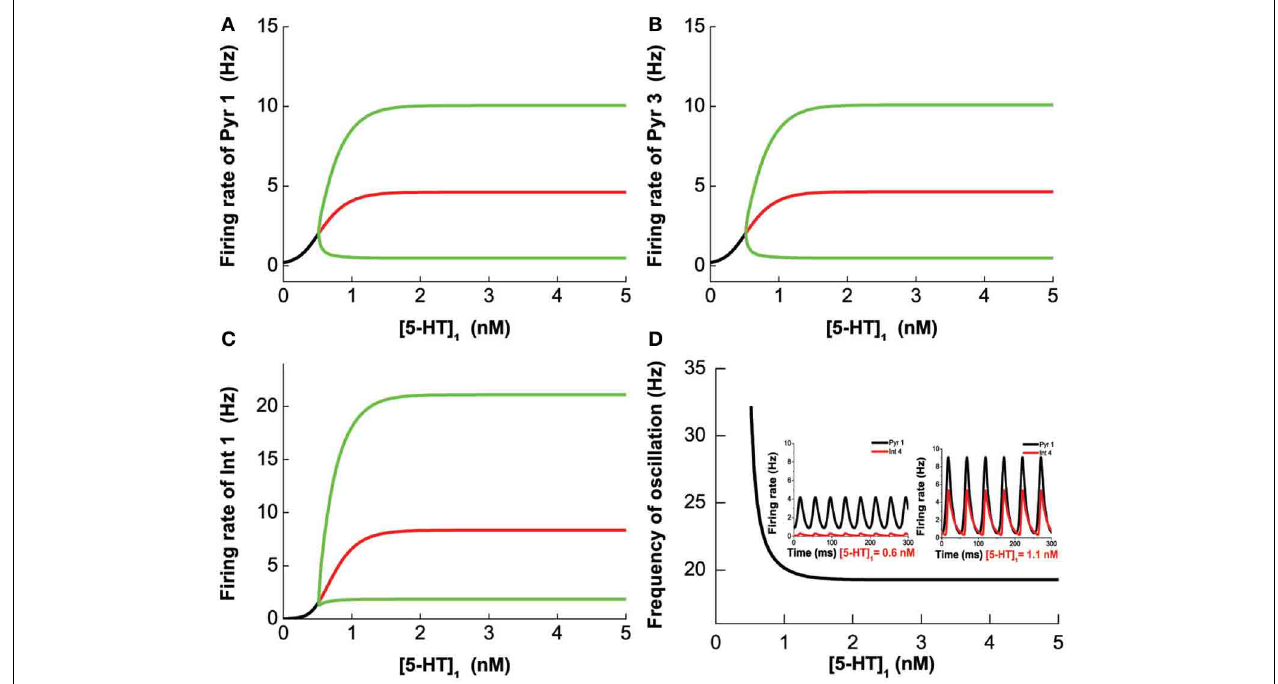
FIGURE 12 | 5-HT1A selective agonist/antagonist effects on the network behavior. The oscillation merges through Hopf bifurcation at [5- HT ] 1 = 0 . 516nM. The amplitude increases with increasing [5- HT ] 1 and reaches a plateau after almost all of 5-HT1A receptor are blocked. Firing rate of pyramidal cell (D1 + 5-HT1A) (A) ,